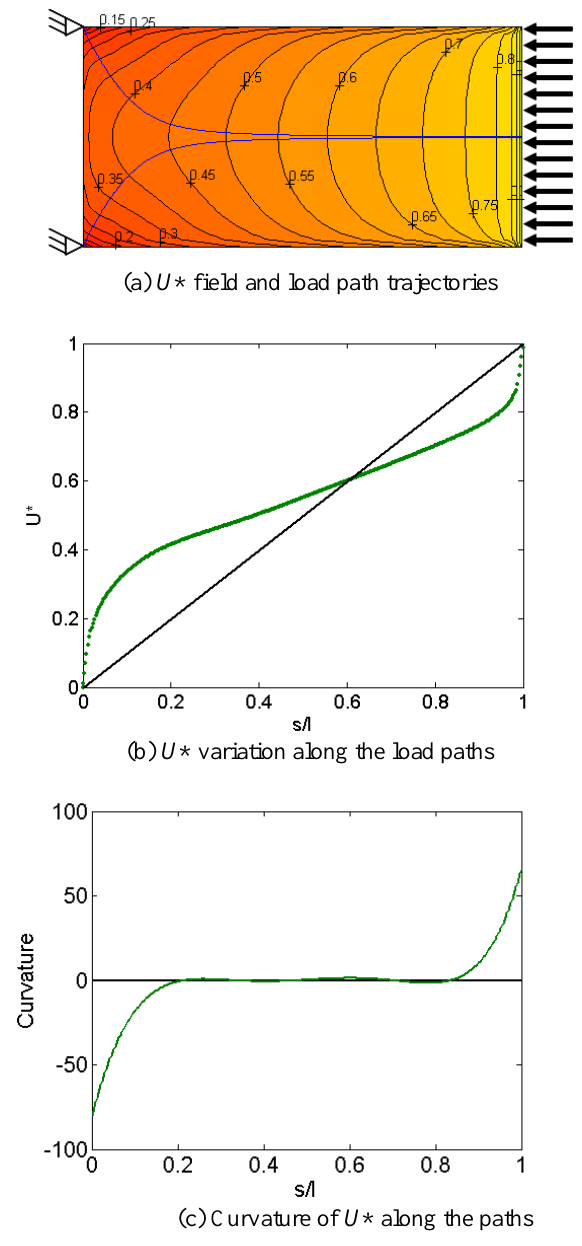
Fig. 20. Load paths based on U * for rectangular structure with distributed loading in the x -direction